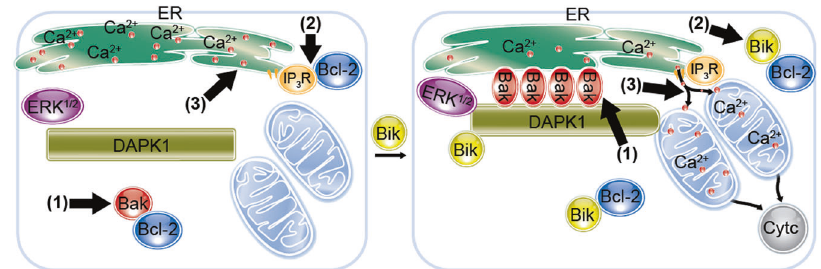
Fig. 7 A schematic depicting that Bik ful fi lls several functions to facilitate cell death. (1) Bik dissociates Bak/Bcl-2 and interacts with DAPk1 to form a complex with Bak that forms multimers and anchors DAPk1 to the ER to increase the contact sites of ER and mitochondria, (2) Bik disrupts the interaction between Bcl-2 and IP 3 R to cause calcium release, and (3) ER-associated Bak interacts with DAPk1 to facilitate mitochondrial